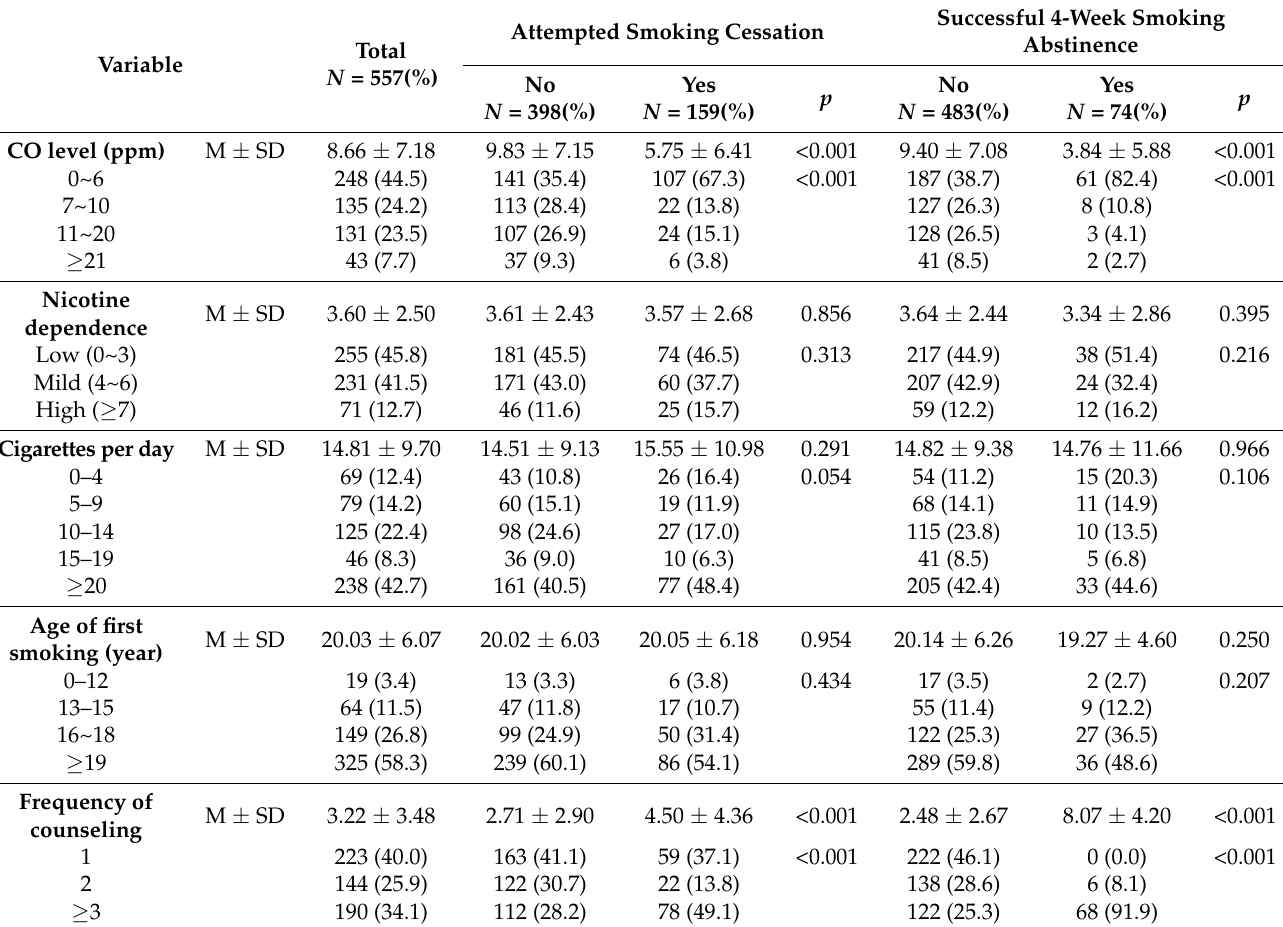
Table 3. Attempted smoking cessation and successful four-week smoking abstinence by smoking-related